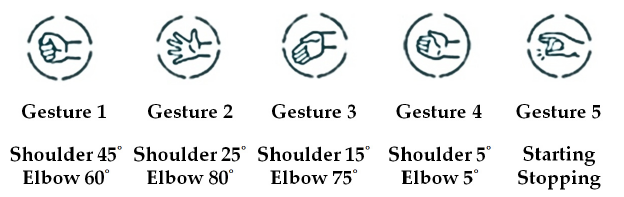
Figure 21. Gesture settings for the target angle, which was selected in accordance with the user’s needs.